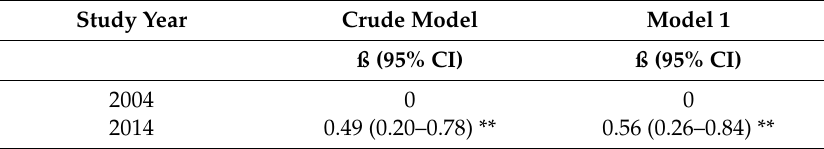
Table 4. The association between study year (2014 versus 2004) and mean fasting plasma glucose levels among 25–74 year old citizens, Yangon, Myanmar, from linear regression analysis.